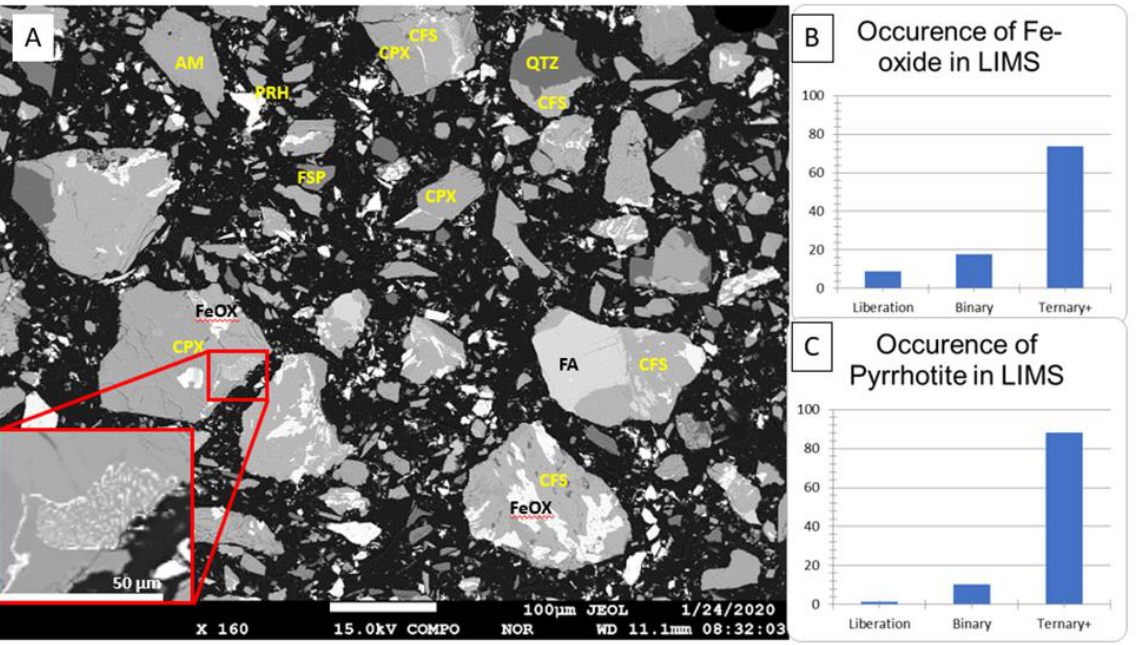
Figure 7. ( A ) Back-scattered electron image of R2/l LIMS1 magnetic concentrate. Abbreviations: AM = amphibole; CPX = clinopyroxene; CFS = clinoferrosilite; FA = fayalite; QTZ = quartz; FSP = potassium feldspar; FeOX = magnetite; PRH = pyrrhotite. Occurrence of LIMS1 concentrate: ( B ) magnetite and ( C ) pyrrhotite.